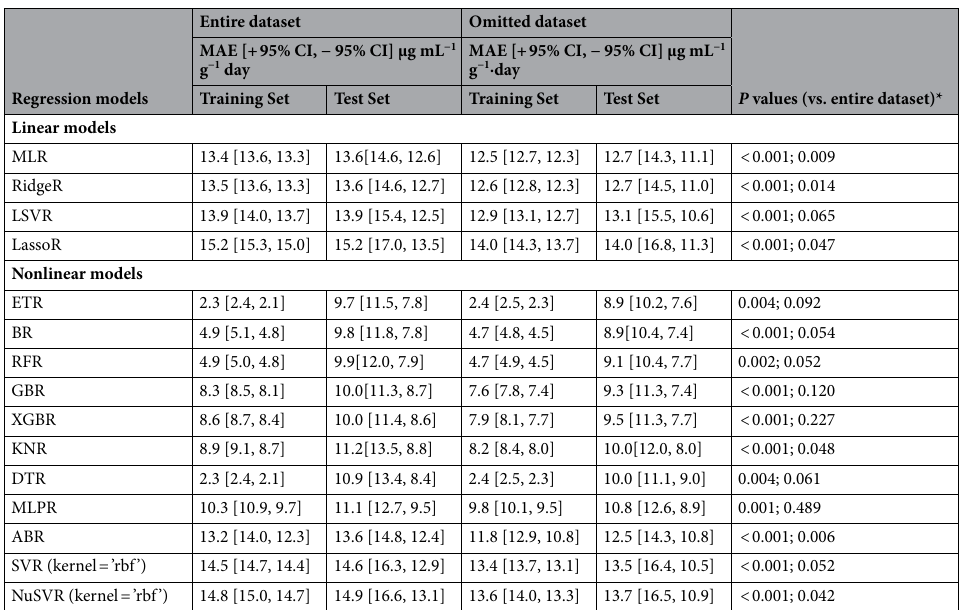
Table 3. An overall comparison of mean absolute error (MAE) at 95% confidence intervals (CI) for the prediction of dose-adjusted concentrations of lamotrigine in the derivation cohort for models using two datasets. MLR multiple linear regression, RidgeR ridge regression, LassoR lasso regression, LSVR linear-support vector regression, ETR extra-trees’ regression, KNR k-nearest neighbor regression, BR bagging regression, RFR random forest regression, XGBR XGBoost regression, GBR gradient boosted regression, DTR decision tree regression, SVR support vector regression, NuSVR nu-support vector regression, MLPR multi-layer perceptron regression, ABR AdaBoost regression. * P values for the training set (the left side of the semicolon) and the test set (the right side of the semicolon),